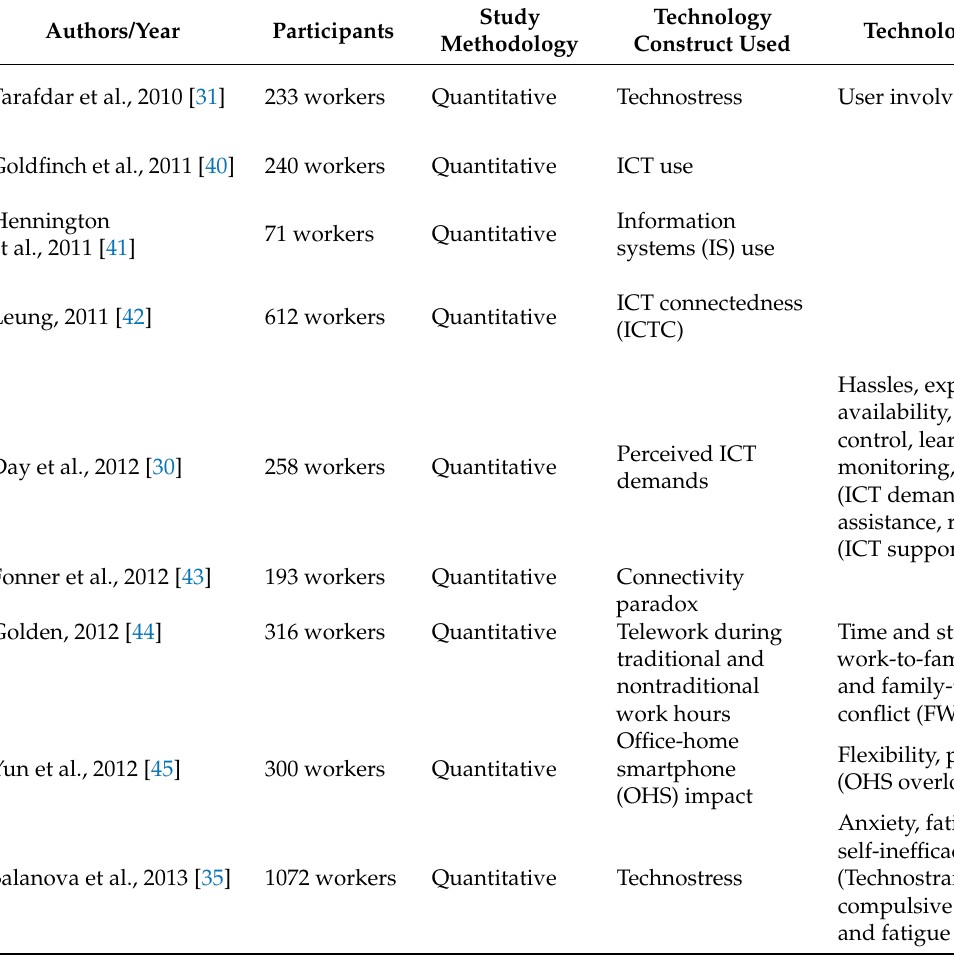
Table 1. Characteristics of included